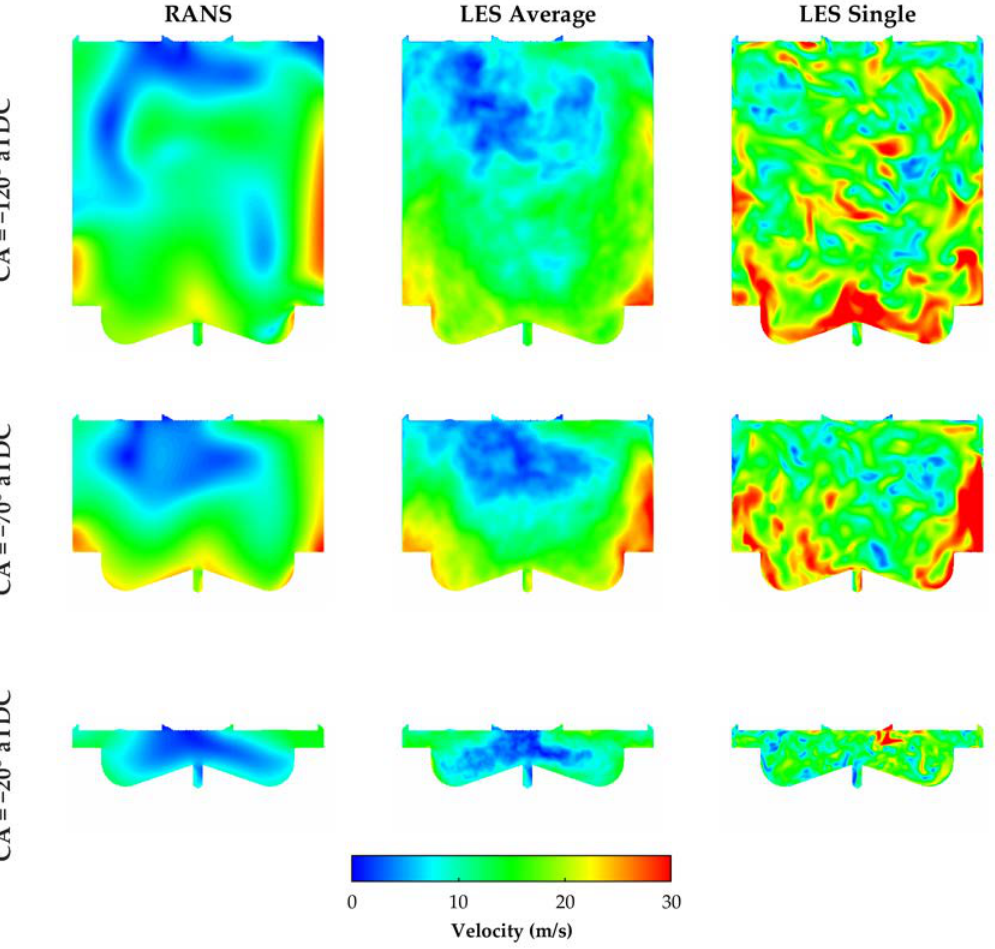
Figure 6. In-cylinder velocity field of the RANS, the average LES and a single LES cycle at three different positions during compression.